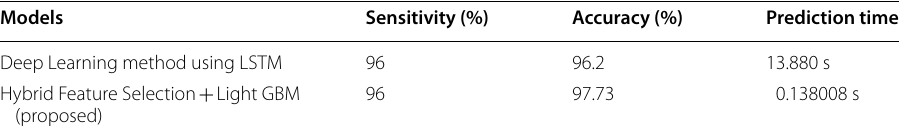
Table 15 Comparison of the proposed model with Lin et al. [13]